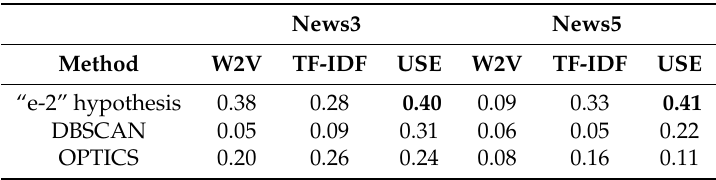
Table 3. V-measure for News3 and